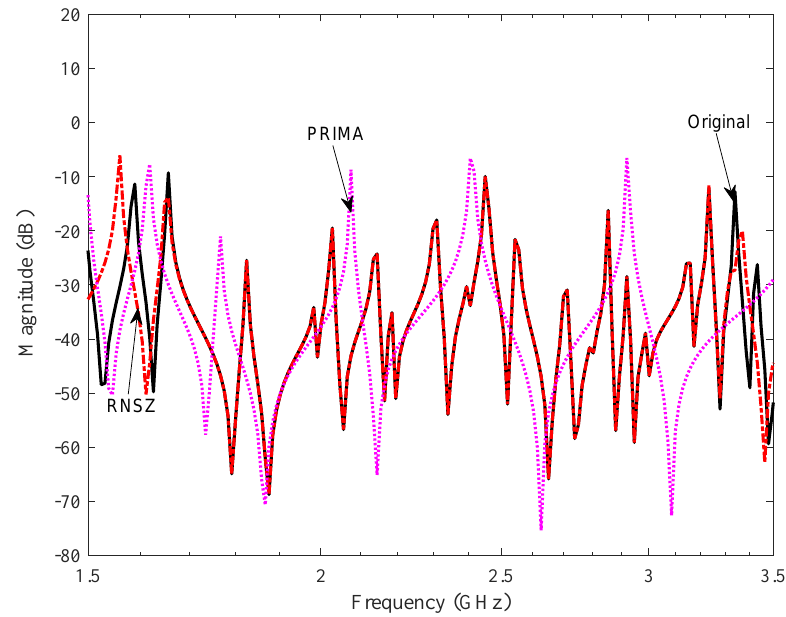
Figure 11. System frequency response of a spiral inductor with original system order of n = 1008. The selected large span of frequency now cover over 2 GHz of frequency range, i.e., from 1.5 GHz to 3.5 GHz. A minimum ROM of order N = 50 is required by RNSZ method to match the response. However, with similar ROM (N = 50), the PRIMA method missed out most of the response and peaks of the original system.